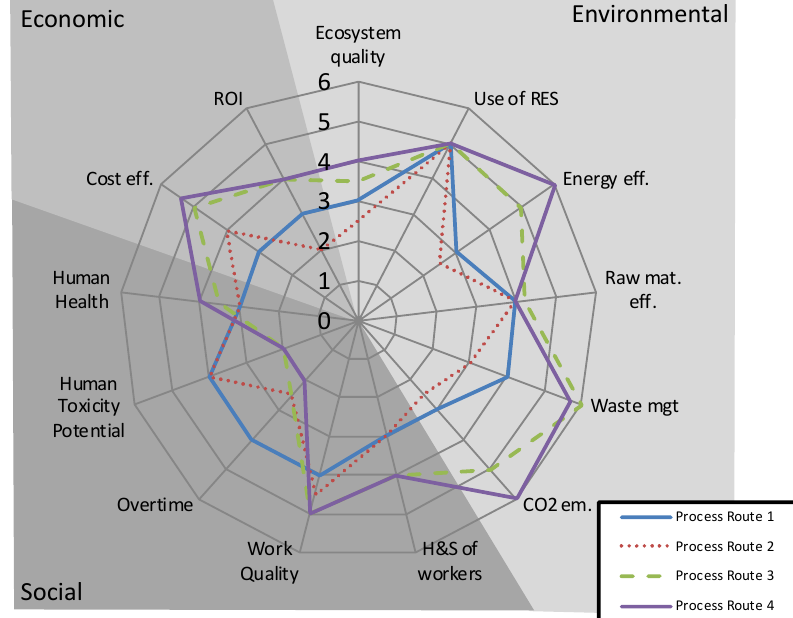
Figure 11. Radar diagram for comparing the four process routes for a low demand scenario.